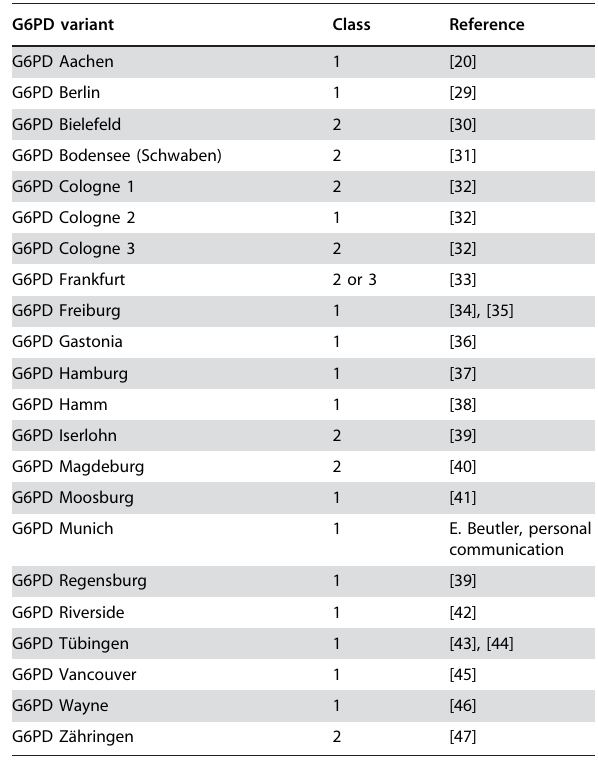
Table 1. Classification of G6PD variants from German ancestry .. ... .... ... ... .... ... ... .... ... ... .... ... ... .... ... ... .... ... ... ....